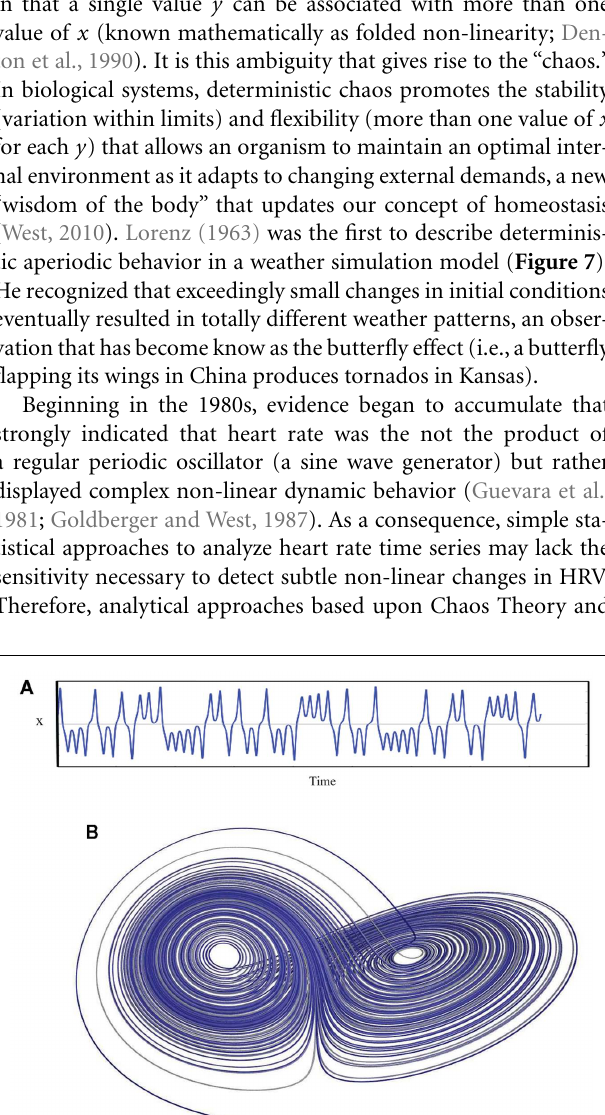
temperature difference between the top and the bottom of the gaseous system, and β = a geometric expression, the ratio of width to height of the containing holding the gaseous system. Lorenz used 10 for σ , 28 for ρ and 8/3 for β . x ( t ) amplitude of the convection current, y ( t ) temperature diffusion behavior (temperature difference between rising and falling air currents), and z ( t ) normal temperature deviations. Some applets that can be used to create the Lorenz attractor are found at the following websites: www.cmp.caltech.edu/ ∼